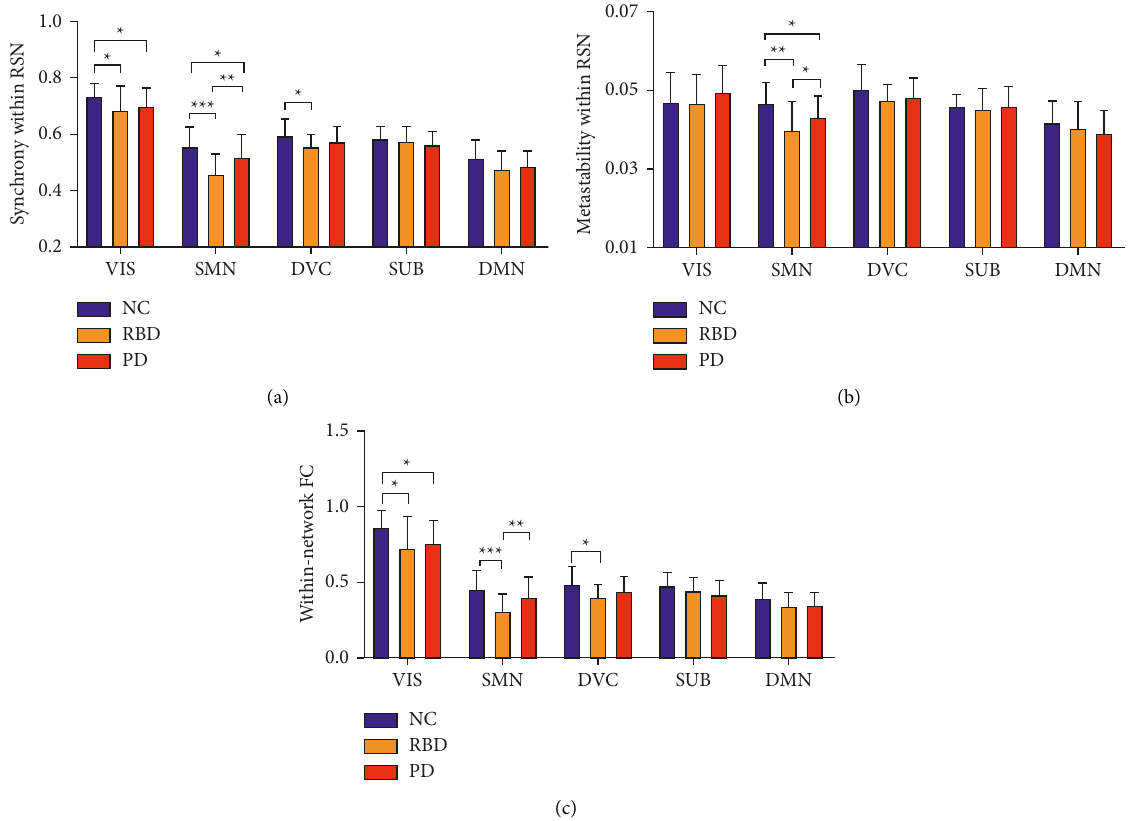
Figure 3: The differences in neuroimaging measures within RSNs between groups. (a) The difference in synchrony within RSN between groups. (b) The difference in metastability within RSN between groups. (c) The difference in within-network FC between groups.